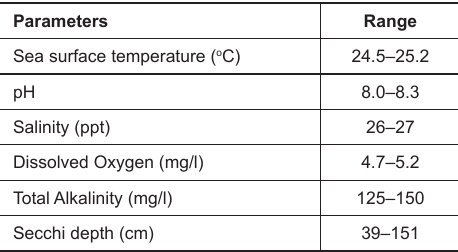
Table 1. The range of physico-chemical parameters observed during the study period